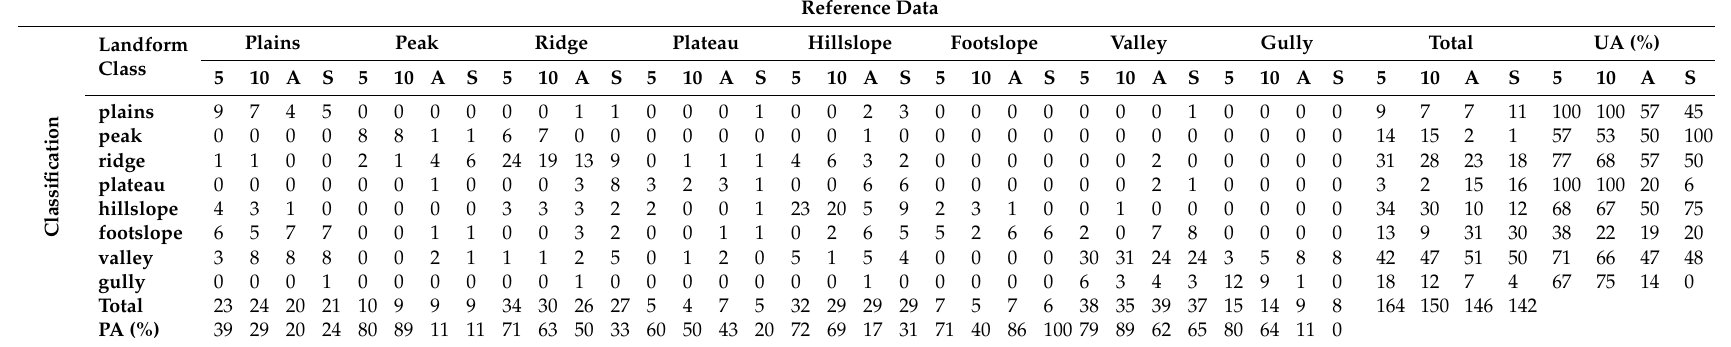
Table A4. Error matrix based on classified landform units for the geomorphons approach for the four different DEMs (5 = 5 m, 10 = 10 m, A = Aster 30 m, S = SRTM 30 m) with producer’s accuracy (PA) and user’s accuracy